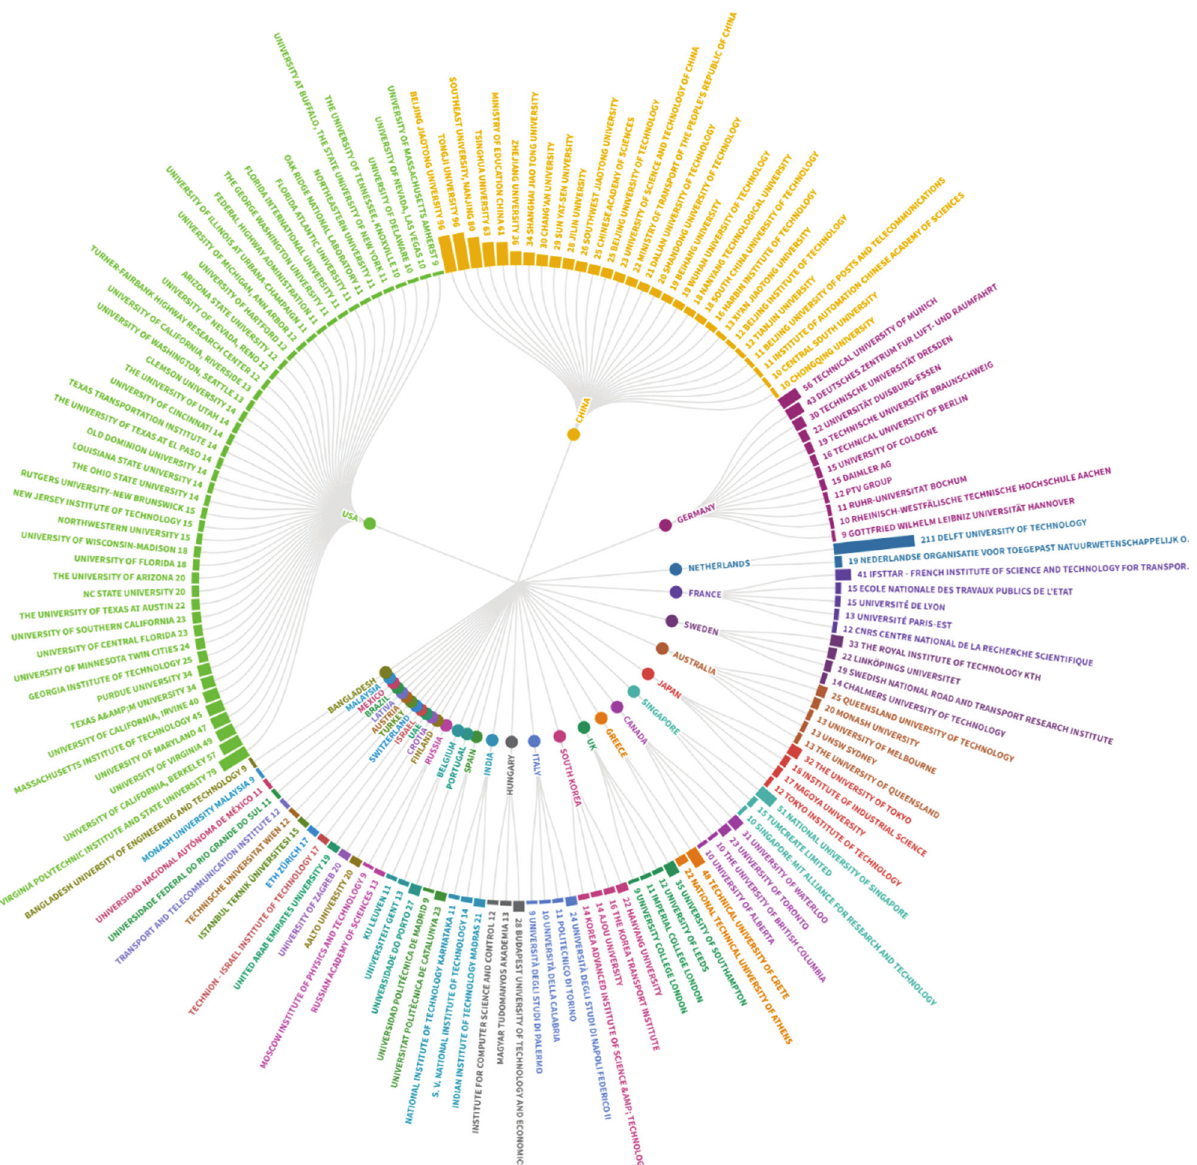
Figure 2: Radial plot depicting the involved institutes across the